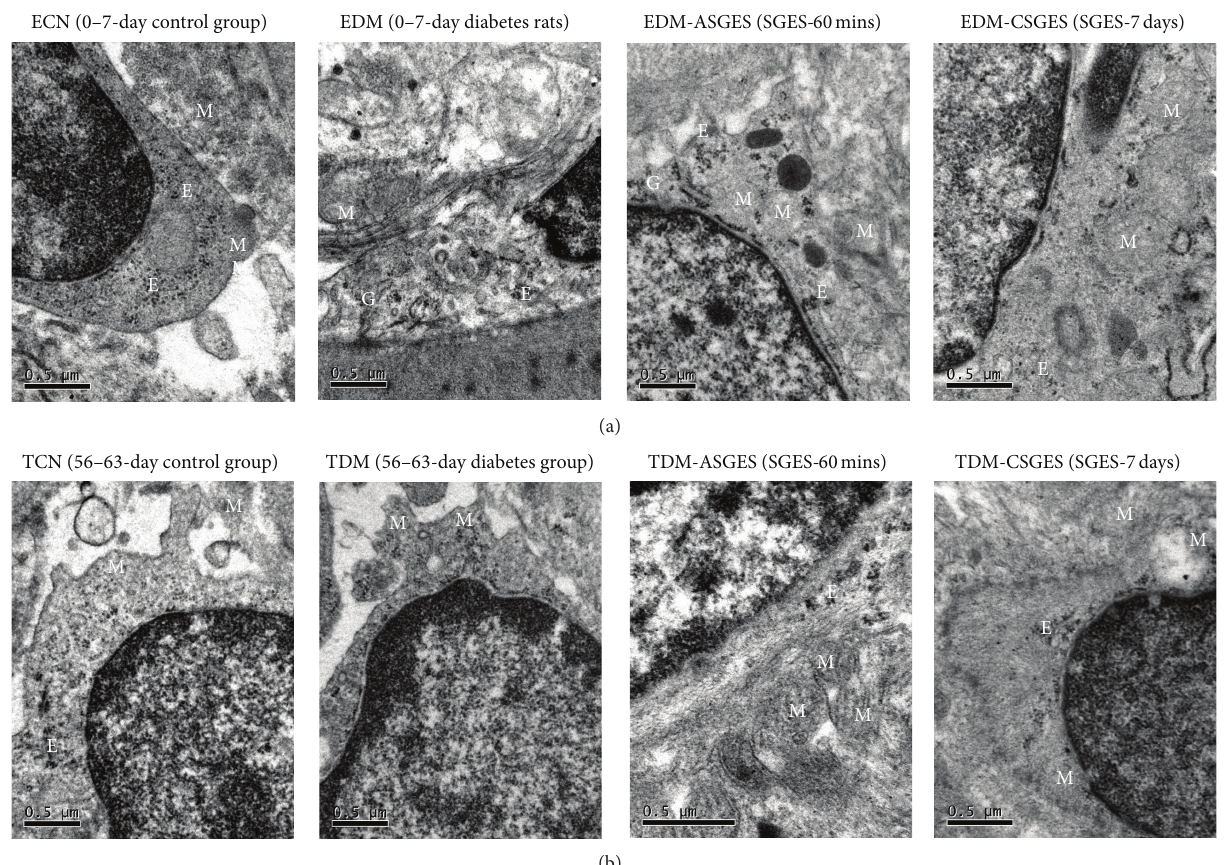
Figure 3: (a) Ultrastructure images of EGC in rat myenteric plexus of ECN, EDM, EDM + ASGES, and EDM+CSGES. Smooth endoplasmic reticulum (letter E), Golgi apparatus (letter G), mitochondria (letter M), and filaments are abundant in cytoplast of ECN and EDM. The number of mitochondria and filaments increased after ASGES and CSGES. And lysosome can be observed in EDM after ASGES. (b) Ultrastructure images of EGC in TCN, TDM, TDM + ASGES, and TDM + CSGES. Mild vacuolization of mitochondria can be observed in cytoplast of TCN. Dilation of endoplasmic reticulum and swelling of mitochondria in cytoplast can be observed in TDM and the filaments decreased seriously. The number of mitochondria and filaments increased after ASGES and CSGES. Note: ASGES: SGES-60 mins; CSGES: SGES-7 days, 60